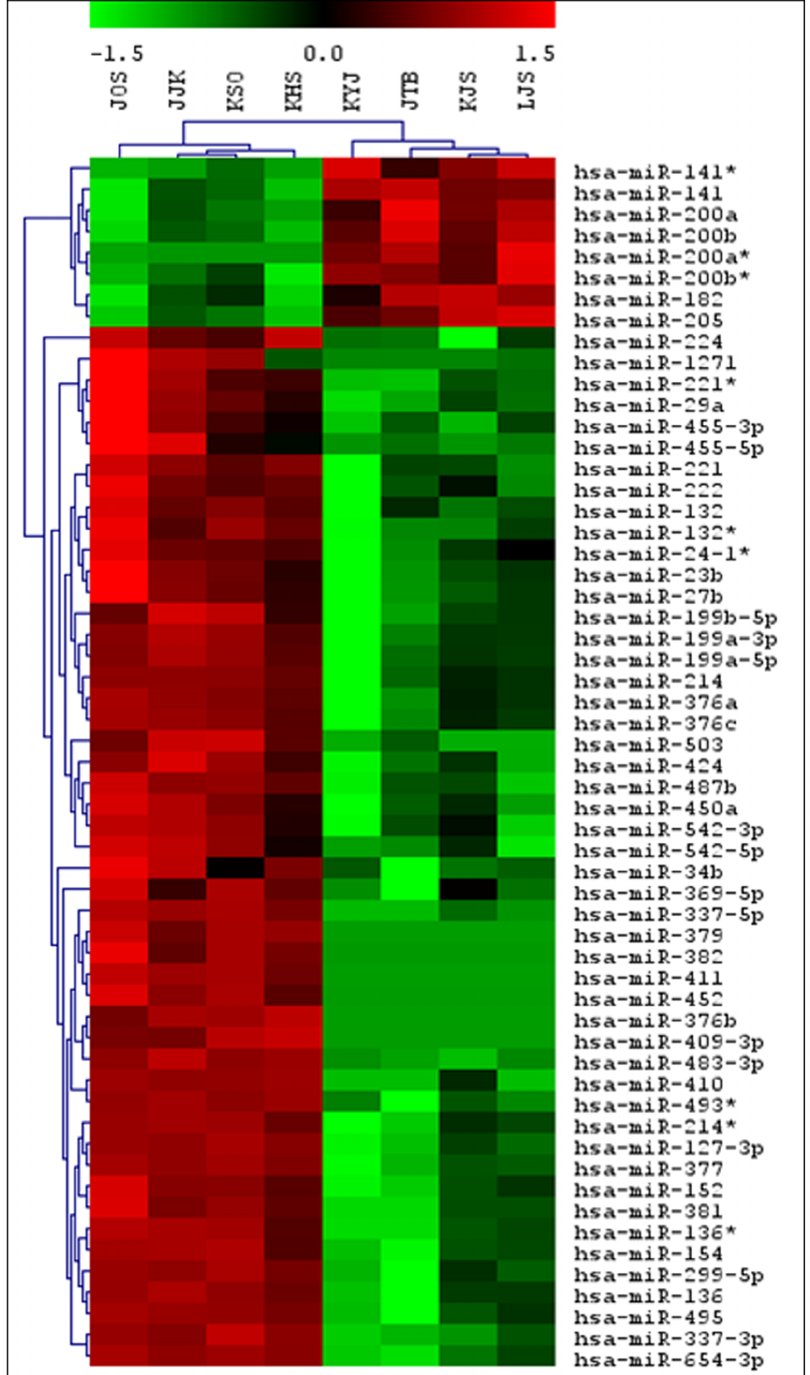
Figure 2. Unsupervised hierarchical clustering of four endometrioid adenocarcinoma and four normal endometrial tissues. foot note: Samples were clustered according to the expression profile of 57 miRNAs differentially expressed between tumor (right four) and non-tumor (left four) samples. The level of miRNA expression is color-coded. Red , higher miRNA expression; green , lower miRNA expression; black , no difference.